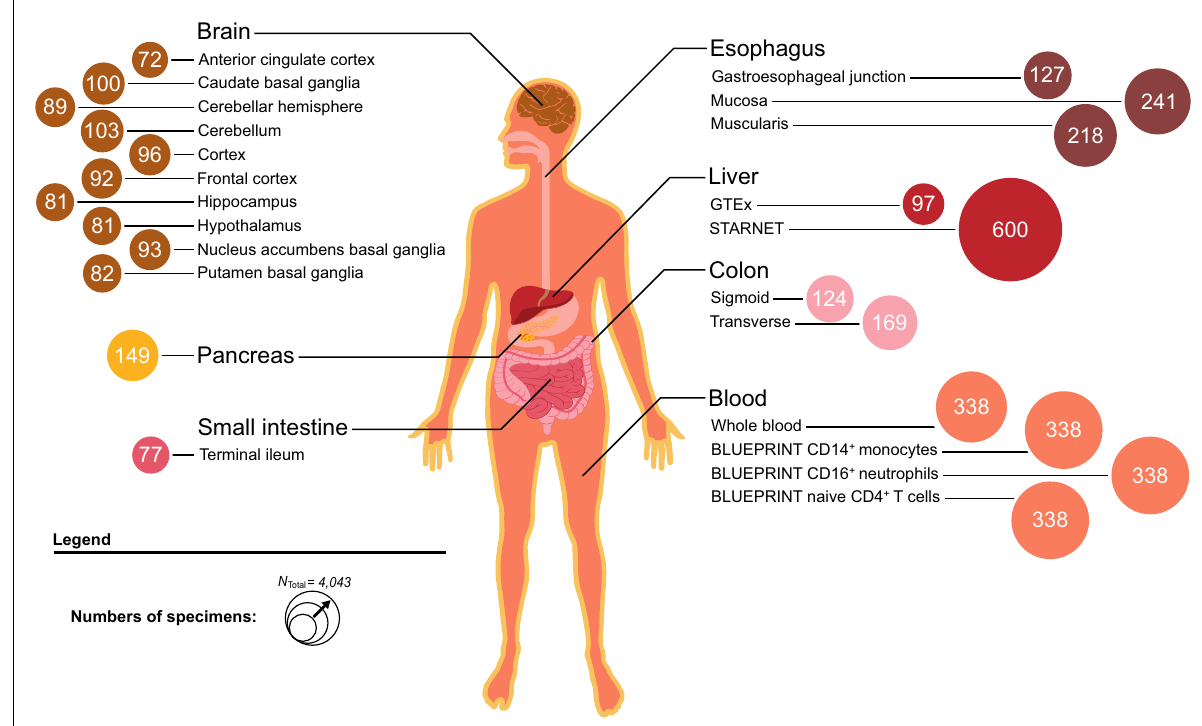
Fig. 1 Selection of 23 tissue and cell types to perform transcriptome-wide association analyses (TWAS) for gut-brain axis (GBA) diseases. We selected 23 tissues and cell types previously found to contribute to the heritability of psychiatric or immune-mediated disease (Methods). Cross-tissue TWAS training and imputation models were used using transcriptome-wide and genome-wide reference data from 4043 reference samples from 23 tissues and cell types (Supplementary Data 2) provided by consortium projects GTEx, STARNET, and BLUEPRINT (Methods): gastrointestinal and liver tissues ( n = 9), brain tissues ( n = 10), whole blood ( n = 1), and immune cell types (CD14 + monocytes, CD16 + neutrophils, CD4 + T-cells; n = 3). Different colors represent biological samples from different tissue classes. The size of the circles corresponds to the number of reference samples of the respective